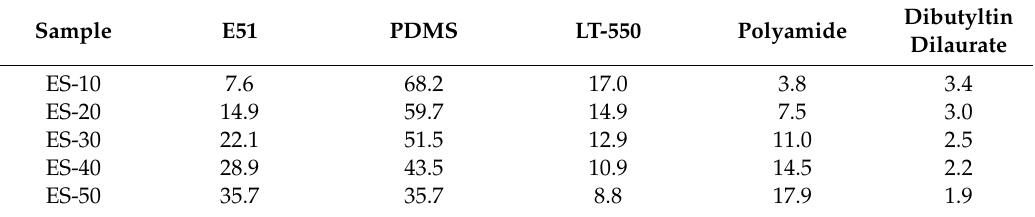
Table 1. Formulation of epoxy modified silicone coating (wt